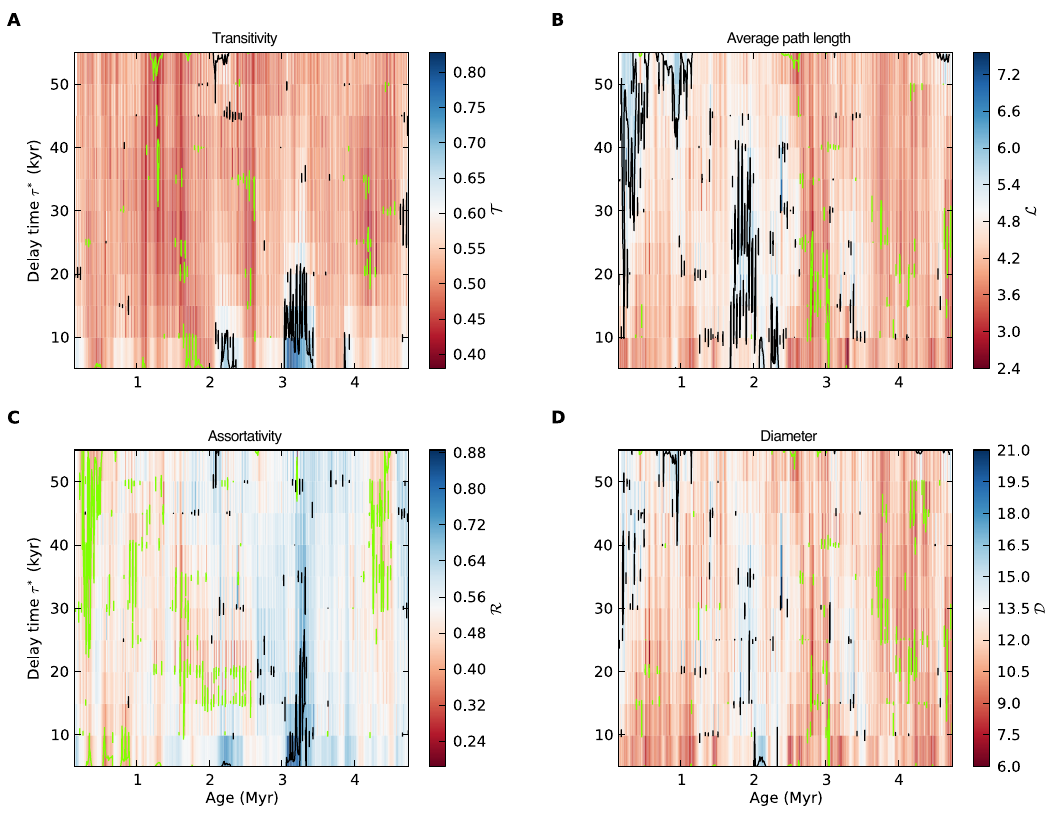
Fig. 15. Dependence of (A) transitivity T , (B) average path length L , (C) assortativity R , and (D) diameter D on the embedding delay time τ ∗ for the dust flux record from ODP site 659. The recurrence window size is fixed to W ∗ =410 kyr with a step size of ∆ W ∗ =41 kyr, the detrending window size to W ∗ D = 500 kyr. Green and black contours correspond to the 5% and 95% quantiles with respect to the test distribution obtained from 10,000 realisations of our null-model. Vertical line-shaped contours are likely to correspond to statistical fluctuations rather than physically significant time intervals (see text). Other parameters were: embedding dimension m = 3, the threshold was chosen to yield a fixed edge density ρ =0 . 05 .